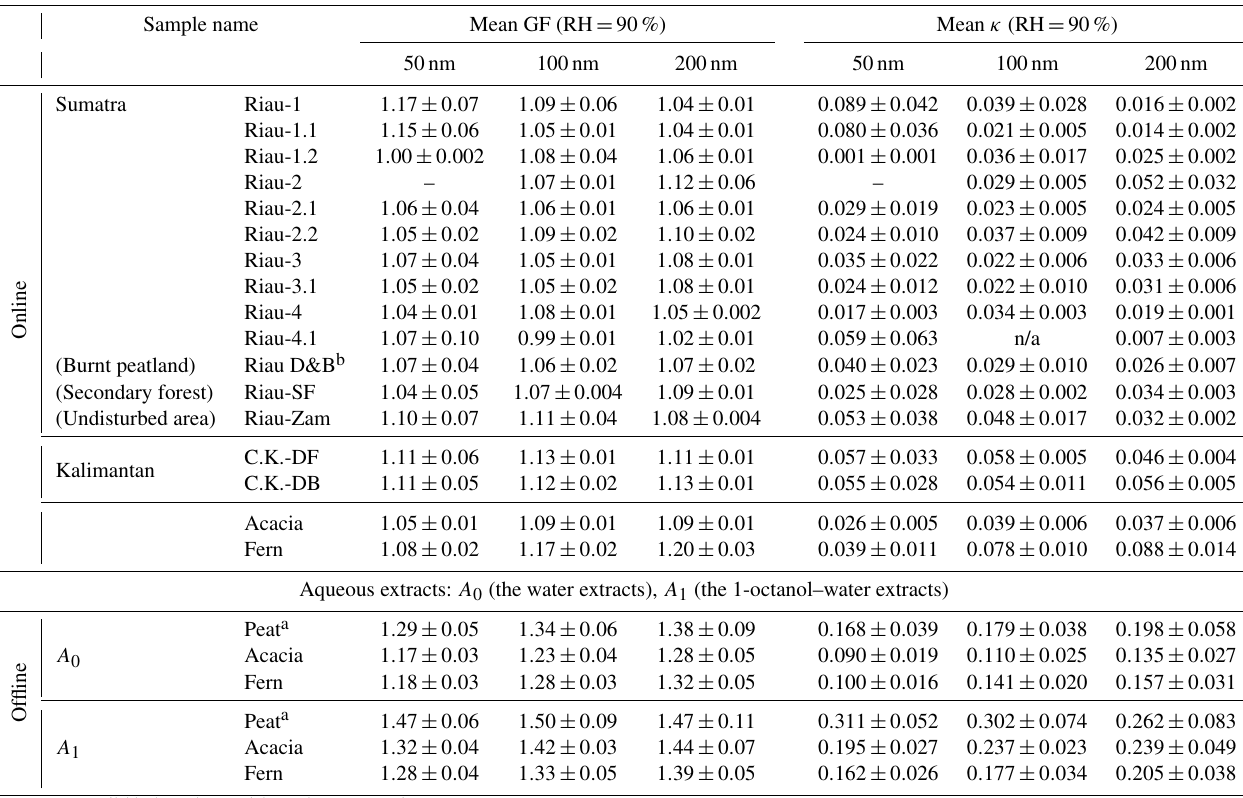
Table 2. Volume weighted mean GF and κ values (average ± 1 standard deviation, SD) of different types of Indonesian peat and biomasses. The results of their aqueous extracts ( A 0 and A 1 ) are also